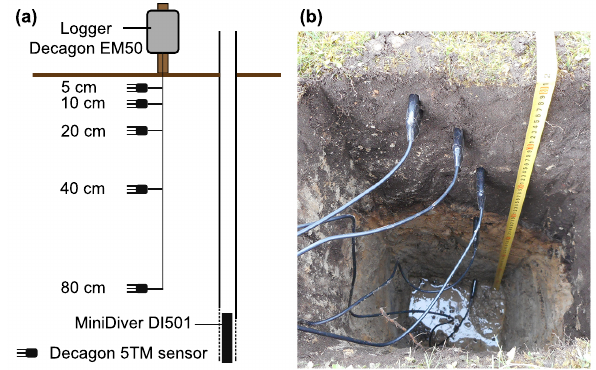
Figure 5. (a) Schematic cross section of the soil moisture mon- itoring stations and nearby phreatic groundwater level monitoring well. (b) Photo of an installation pit with the soil moisture sensors installed at the five